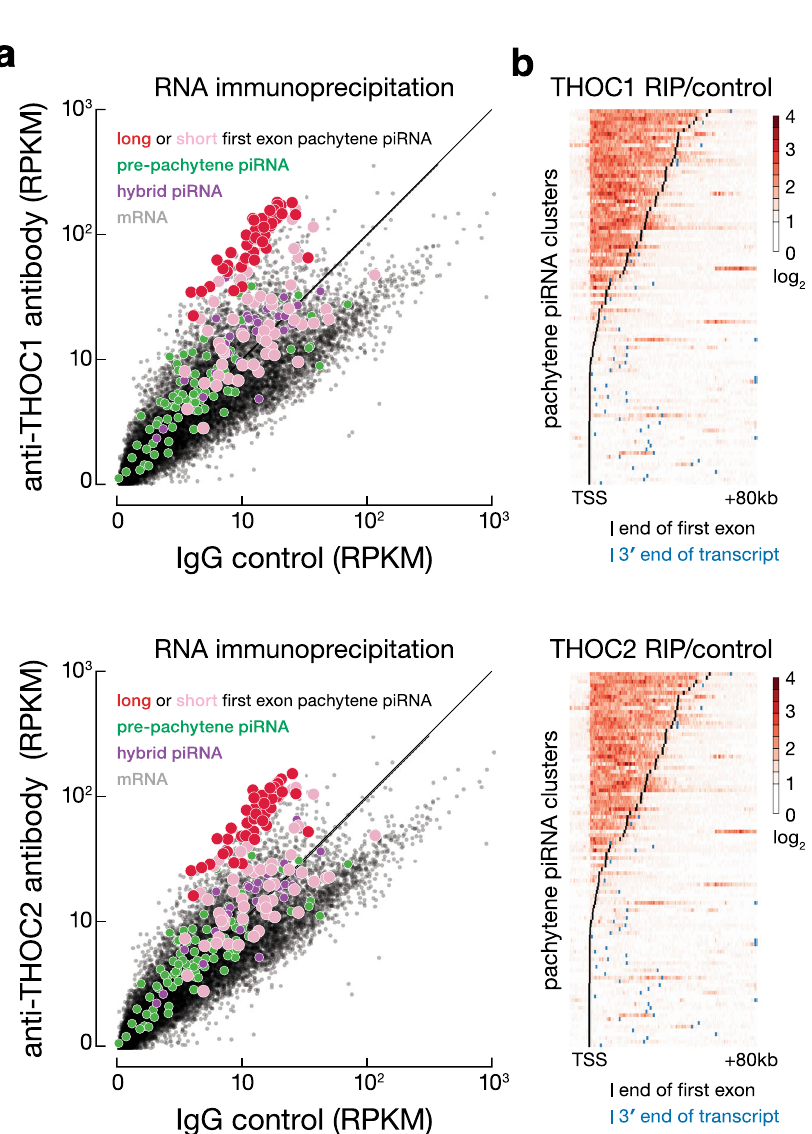
Fig. 4 THOC1 and THOC2 speci fi cally bind precursor transcripts from long intronless and long- fi rst-exon pachytene piRNA clusters. a RIP-seq was used to measure the abundance of RNA bound to THOC1 ( n = 5) or THOC2 ( n = 3) compared to IgG control ( n = 4) in adult testis. Each dot represents the mean abundance normalized for transcript length (RPKM). b Heatmaps report the enrichment of THOC1 or THOC2 binding, measured by RIP-seq, relative to IgG control for pachytene piRNA clusters in adult testis. TSS, transcription start site. Each row corresponds to pachytene piRNA gene, in fi rst- exon (spliced) or transcript (unspliced) length order. For each gene, the black bar denotes the fi rst exon – intron boundary; the blue bar indicates the 3 ′ end of the